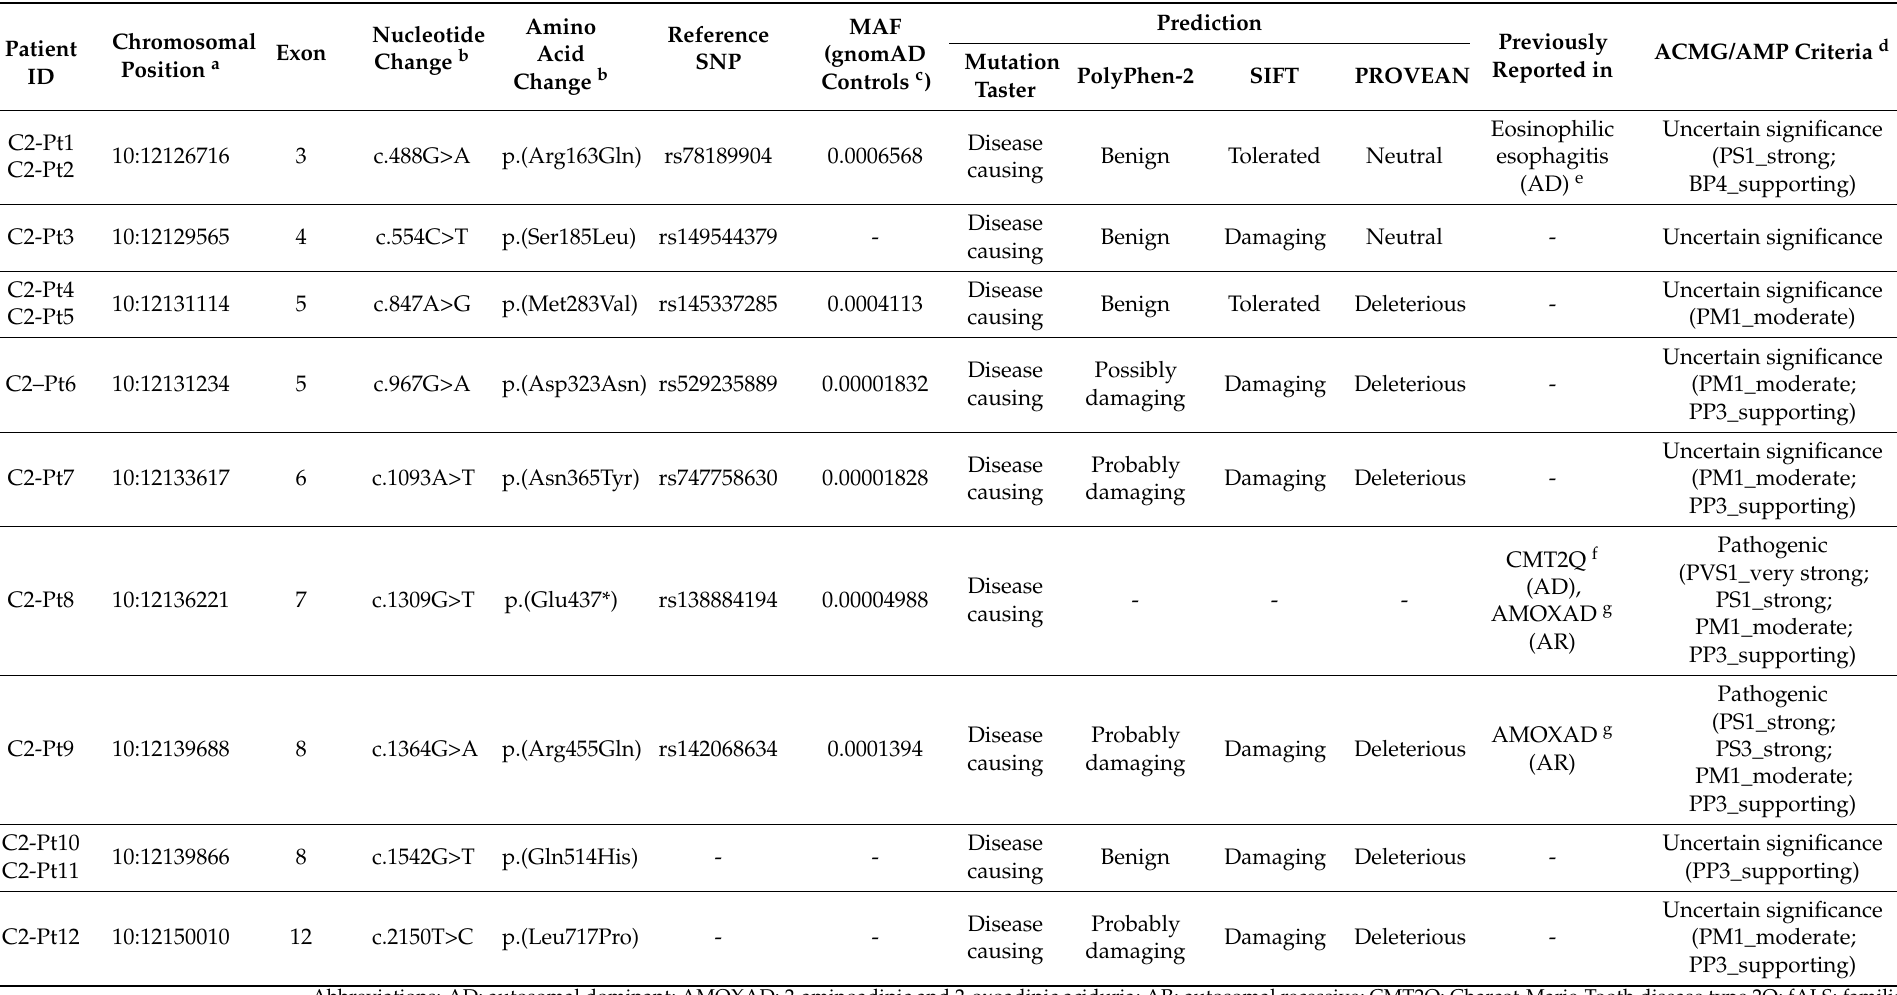
Table 2. Rare heterozygous non-silent DHTKD1 variants predicted to be deleterious identified in familial ALS patients of cohort 2 ( n = 418 ALS